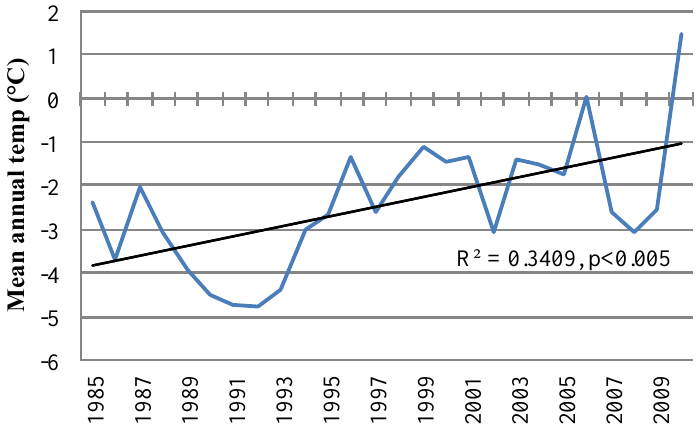
Figure 2. Mean annual temperature in Nain from 1985 to 2010